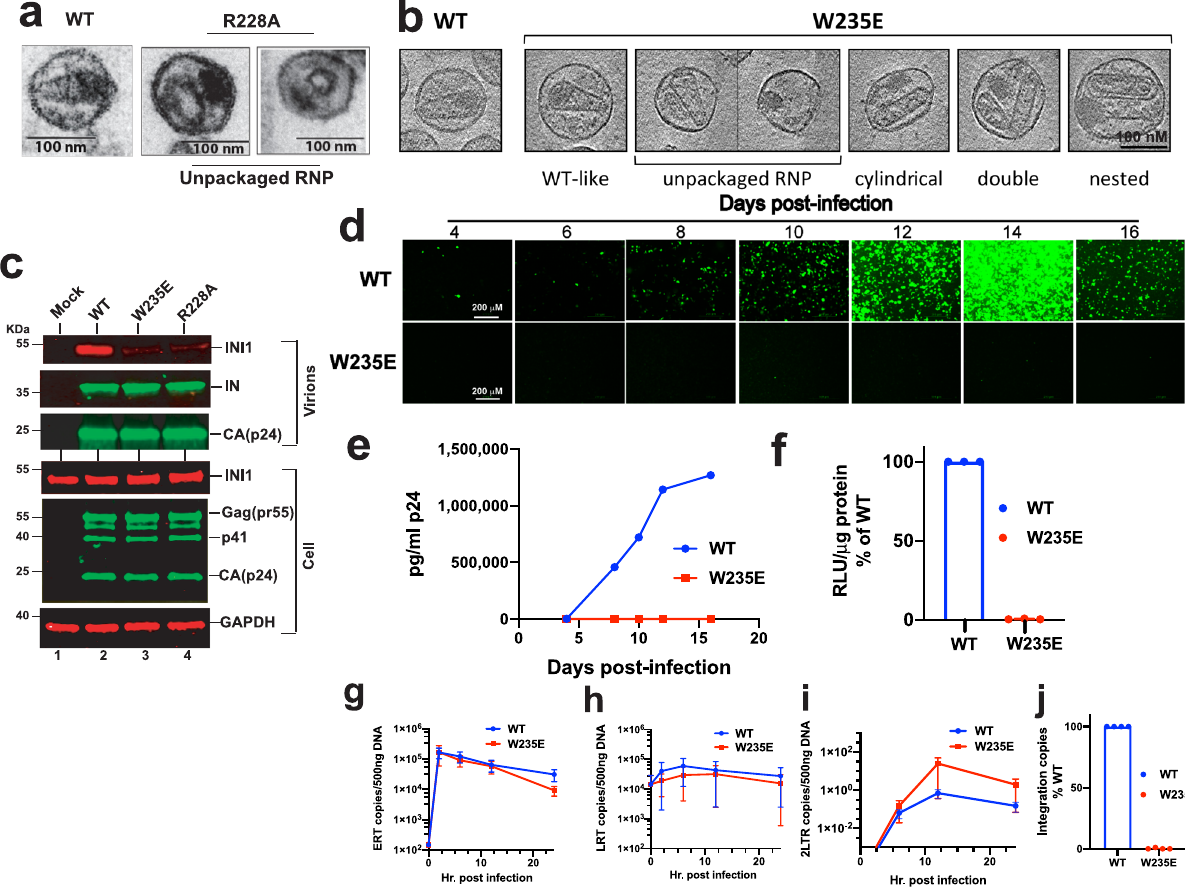
Fig. 6 Particle morphology and replication of INI1-interaction defective IN mutants. a TEM analysis of wild type (WT) and R228A mutant HIV-1NL4-3 particles. Note the empty capsids with unpackaged RNP in R228A mutant. b Cryo electron tomography (CryoET) studies to demonstrate the defect in particle morphology of the virions harboring W235E mutations. Leftmost panel indicates CryoET structure of wild type (WT) particle. The rest of the panels indicate various particle morphologies observed in mutant virions. c IN binding is necessary for INI1 incorporation into HIV-1 virions. The gel images are from one out of three independent experiments. Immunoblot analysis of concentrated WT, W235E, or R228A HIV-1 NL4-3 virions produced in 293 T cells. Top three panels represent immunoblot analysis of concentrated virions and the bottom three panels correspond to producer cell lysates. Western analysis was carried out using α -IN (to detect IN), α -p24 [to detect Capsid (CA, p24) and Gag (pr55)], α -BAF47 (to detect INI1) or α -GAPDH (as loading control) antibodies. Uncropped blots of this Western analysis are provided in the source data. d – j Analysis of replication of W235E mutant. d Fluorescence microscopy images of CEM-GFP cells infected with HIV-1 NL4-3 (25 ng p24 each) of WT or W235E mutant in a multiday infection. e Graphic illustration